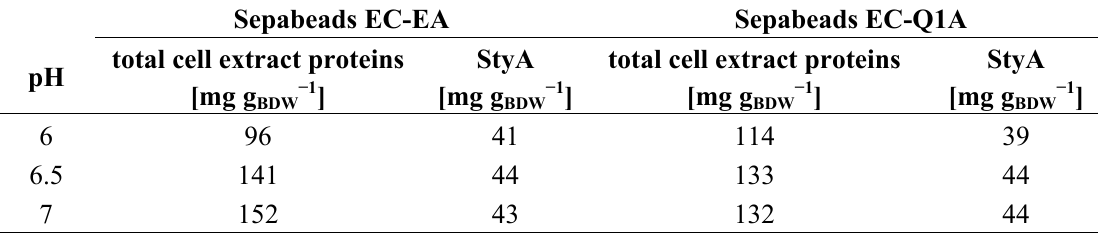
Table 1. Calculated maximum protein adsorption capacities of Sepabeads EC-EA and Sepabeads EC-Q1A according to Langmuir isotherms. Linearizations were performed for the total cell extract proteins and StyA at pH 6, 6.5, and 7. The regressed R 2 values for each linear fit were consistently greater than